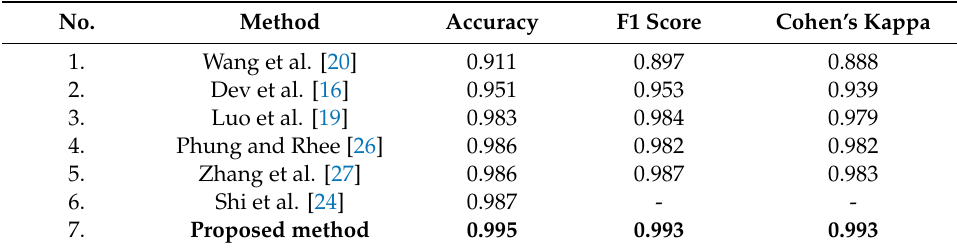
Table 5. Comparison with previous publications.